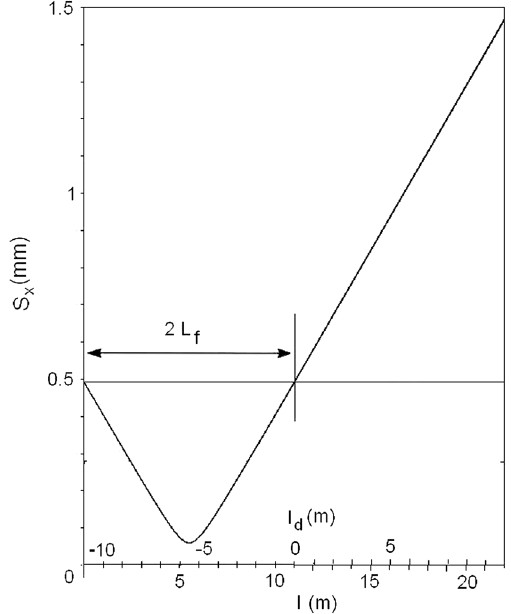
FIG. 12. The universal function describing the envelope for the focusing and defocusing case obtained from the experimental study of a focusing crystal in a 400 GeV =c proton beam. The values for the distance l from the focusing and l d from the defocusing crystal are shown on the abscissa axis with tick marks pointing upwards and downwards, respectively. The thin hori- zontal line corresponds to the initial rms size of the beam of 0.492 mm at l ¼ 0 or l d ¼ 0